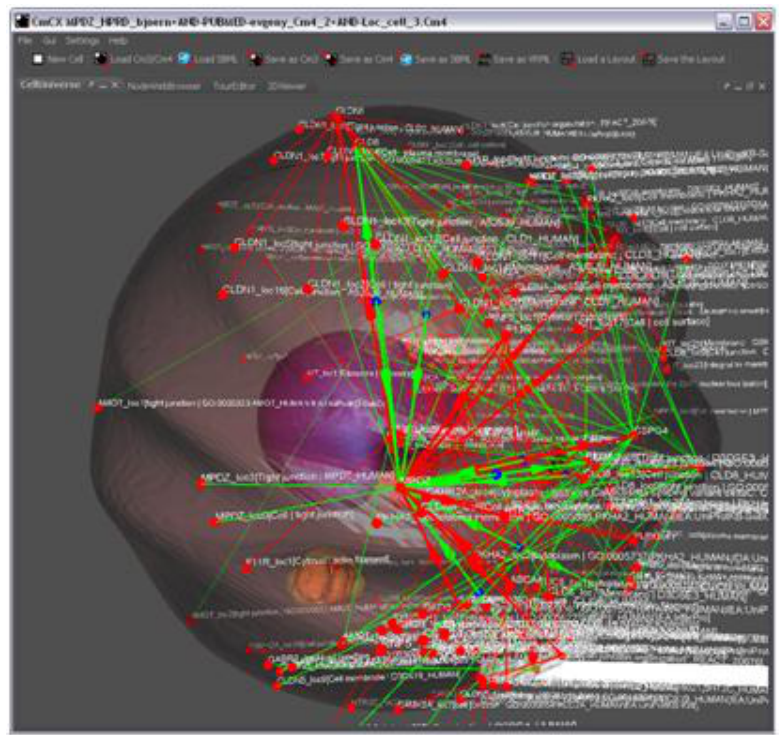
Figure 10: The CmPI visualization from Fig. 7 showing additionally all alternative localization of the enzymes. The information overflow can be limited by using the Focus+Context